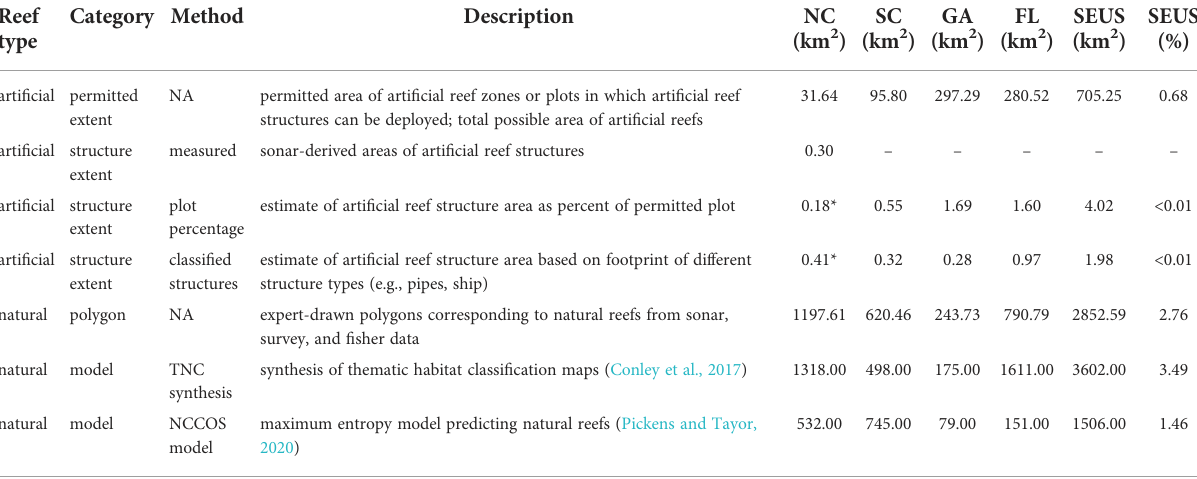
TABLE 1 Approaches for and corresponding estimates of arti fi cial and natural reef